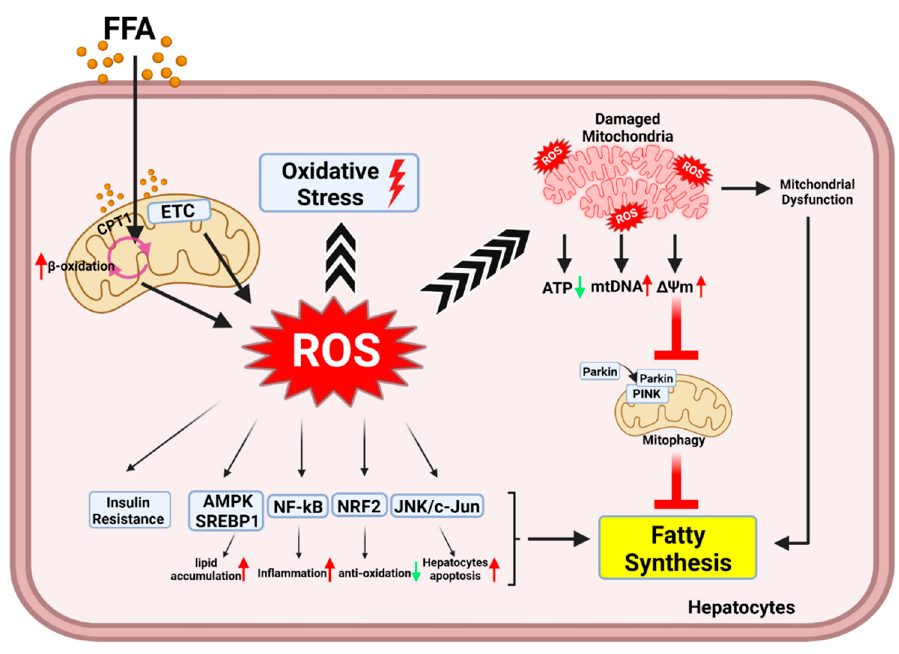
Figure 2. The mechanism of ROS-mediated oxidative stress and lipid metabolism in hepatocytes. In the NAFLD patients, the overload intake of free fatty acids increases fatty acid β -oxidation and electron transport chain activity in the mitochondria. This ultimately leads to an increased release of ROS as byproduct of metabolism. The lots of ROS can directly target mitochondria, resulting in decreased energy metabolism, increased release of mtDNA and mitochondrial dysfunction. At the same time, mtROS leads to disturbance of mitochondrial membrane potential. High mitochondrial membrane potential is not friendly to the occurrence of mitophagy. The reduction of mitophagy reduces the clearance of damaged mitochondria and indirectly increases the fat synthesis. Moreover, high levels of ROS activate AMPK, SREBP1, NF-kB, JNK/cJun, and downregulate NRF2. These protein kinases and transcription factors regulate lipid metabolism, inflammation, antioxidant ca- pacity and hepatocytes apoptosis. Finally, with the increase in insulin resistance, the synthesis of fat is intensified in hepatocytes.